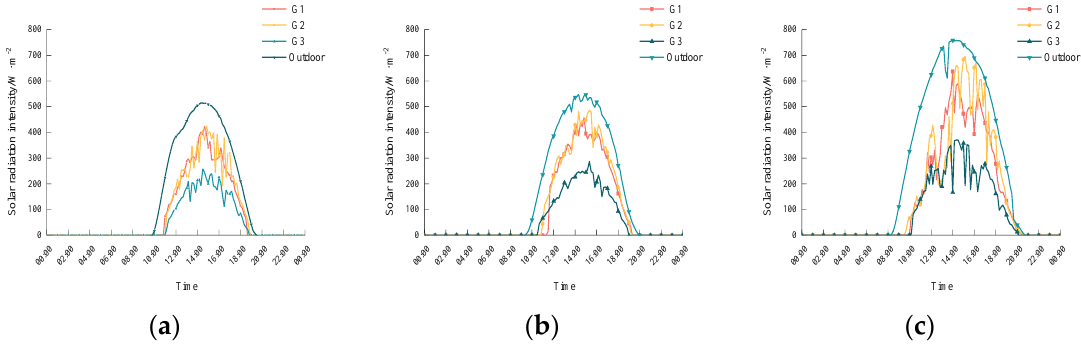
Figure 5. Variation in solar irradiation on typically bright days between January and March. ( a ) 28 January 2022. ( b ) 20 February 2022. ( c ) 31 March 2022.